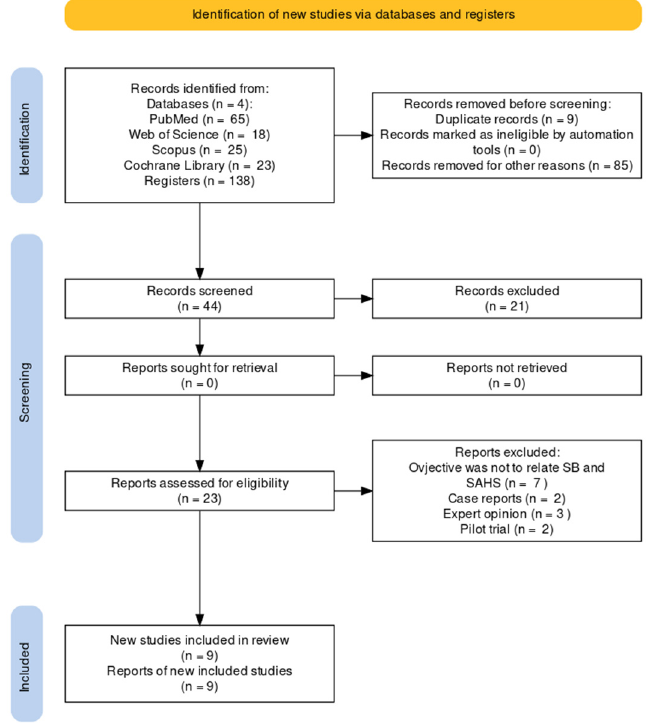
Figure 2. Flowchart outlining the literature search.